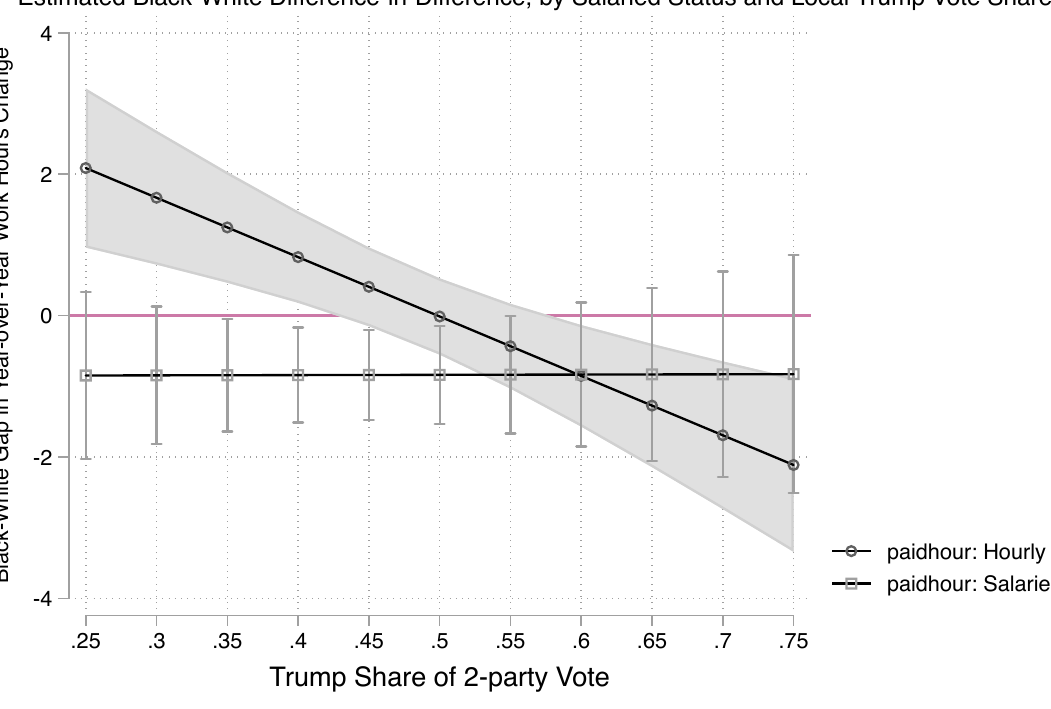
Figure 6: Placebo test: year-over-year change in weekly hours among salaried versus hourly workers. Notes: This figure shows estimates from lagged dependent variable models estimated on sample of prime-age hourly workers employed in the same job year-over-year from November 2015 to March 2017. Models include CBSA, industry, and occupation fixed effects, as well as a triple interaction between local Trump vote share, race, and salaried or hourly status. Probability weights are applied to adjust for survey design, sample attrition, and attrition from wave 1 hourly job. Standard errors are clustered by